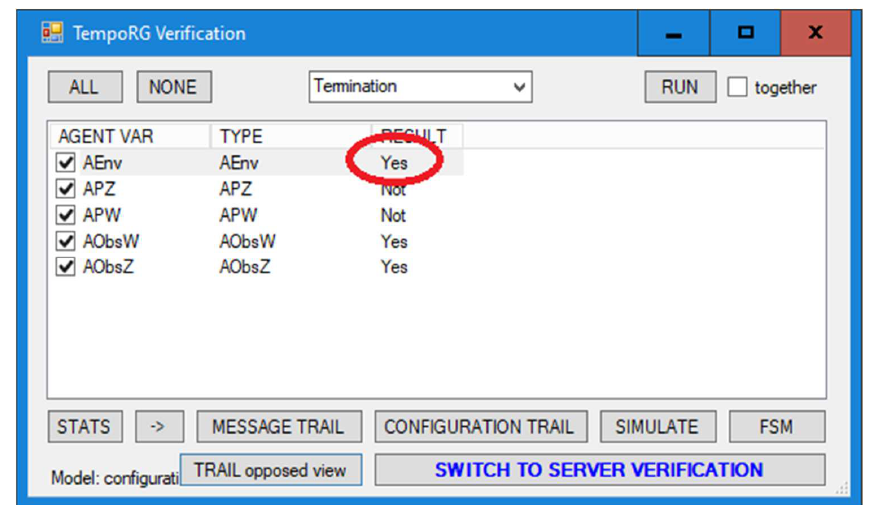
Figure 11. Verifier window showing Aenv agent termination.